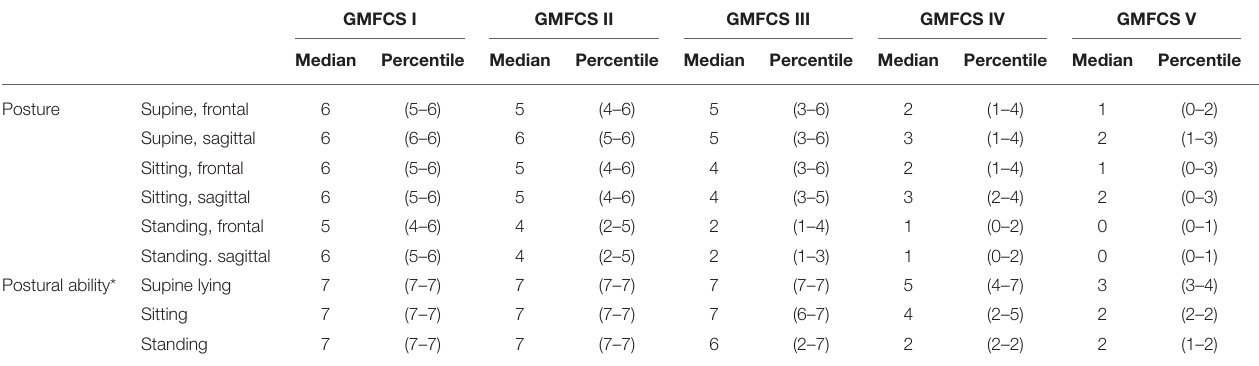
TABLE 3 | Median values with 25 and 75th percentiles for the Posture and Postural Ability Scale scores for posture and postural ability in supine, sitting and standing positions of adults at GMFCS I to